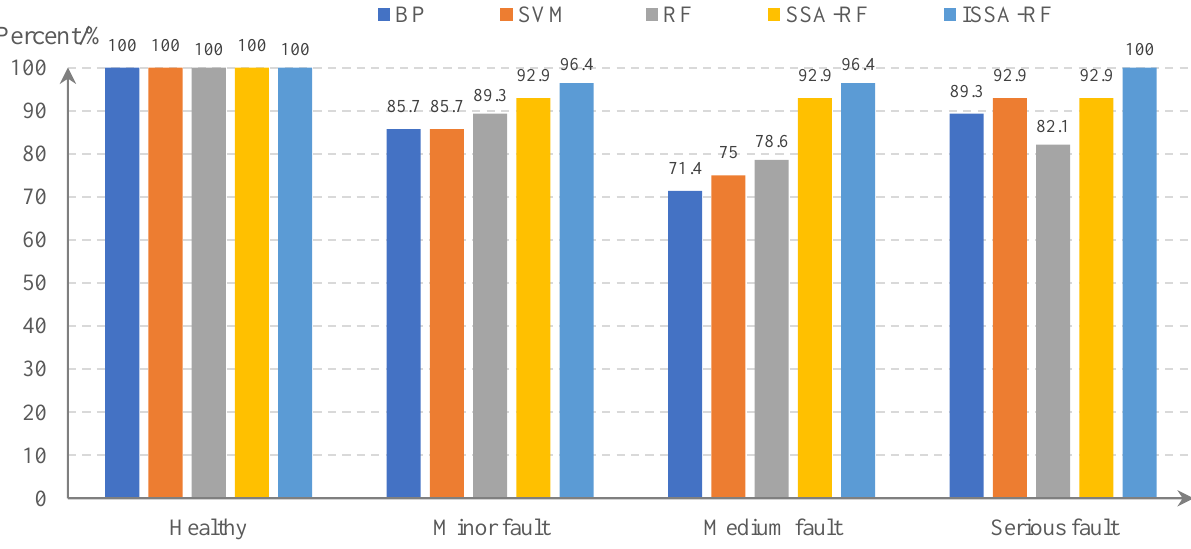
Figure 11. Specific accuracy of different fault degrees (unit: %).